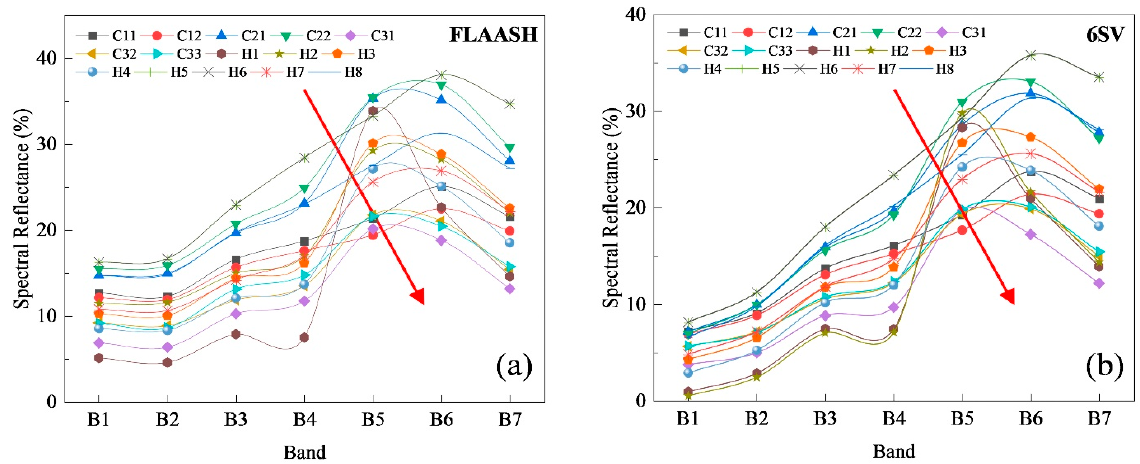
Figure 6. Reflectance spectra of topsoil samples with different atmospheric correction models: ( a ) FLAASH atmospheric correction model and ( b ) 6SV atmospheric correction model.